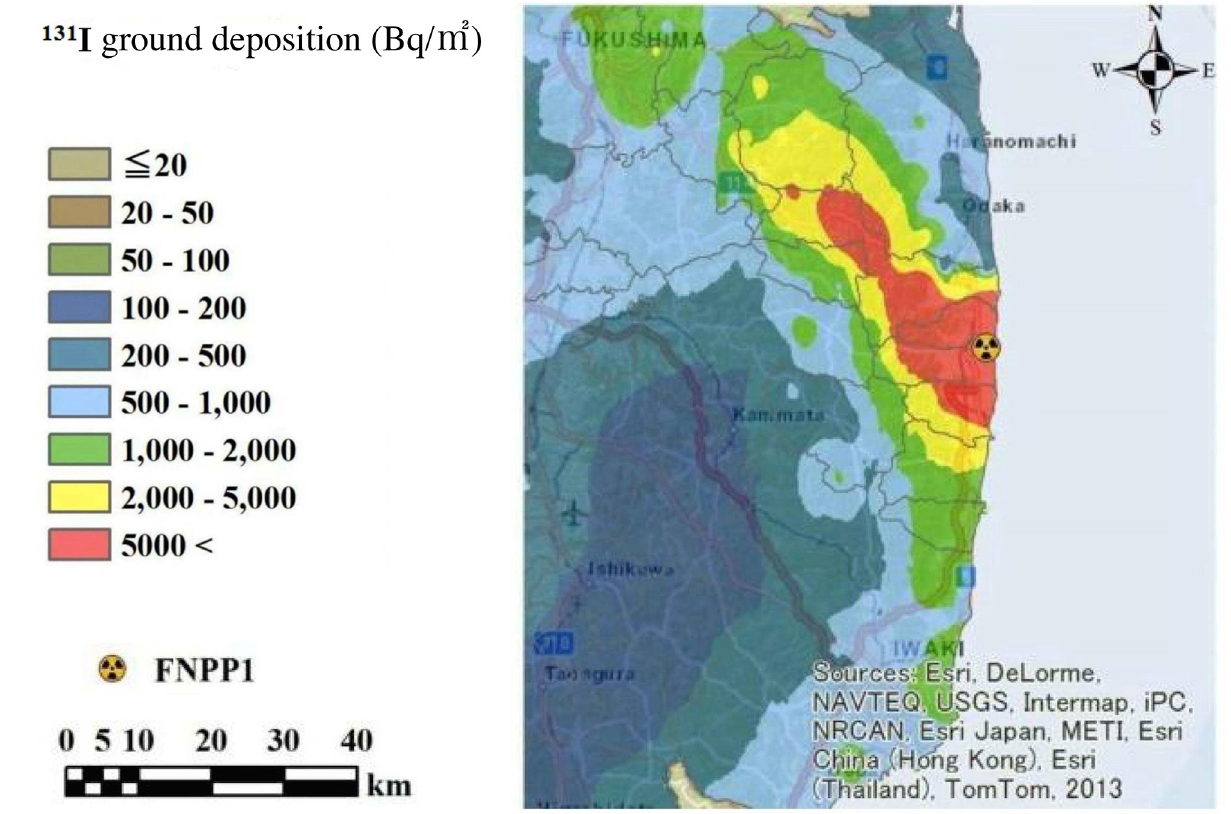
Fig 1. Estimated 131I ground deposition across Fukushima Prefecture as of June 14th 2011. FNPP1: Fukushima Daiichi Nuclear Power Plant.